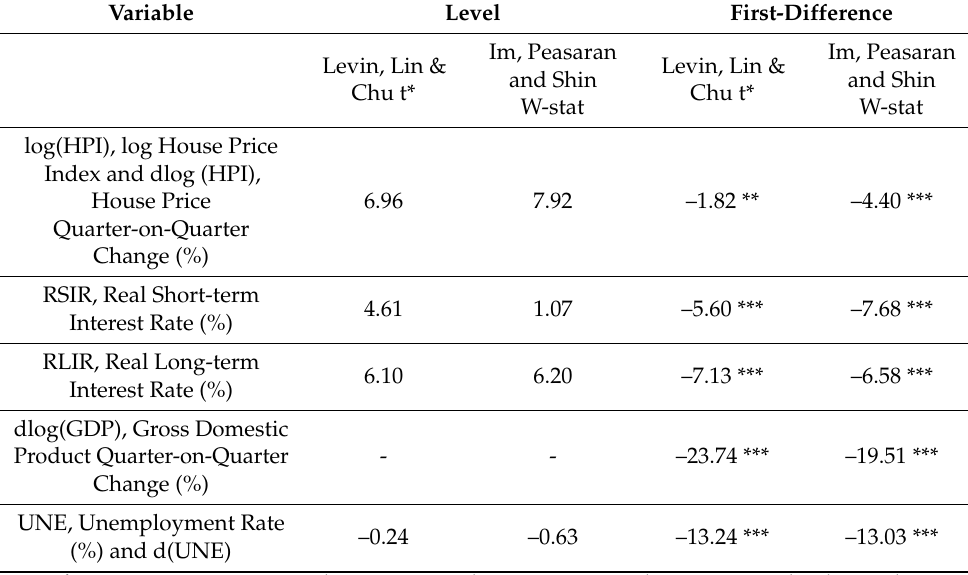
Table 2. Unit Root Tests of Variables, 2015 Q1–2022